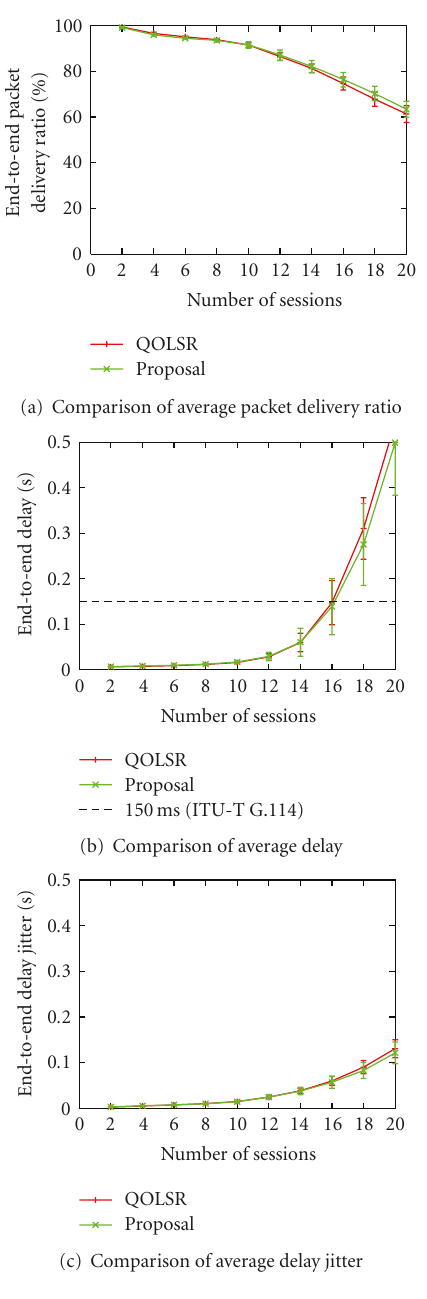
Figure 6: Results of the simulation I (simulation area: 6000 × 6000 m, number of nodes: 100, broadcast rate: 6 Mb/s, packet size: 1292